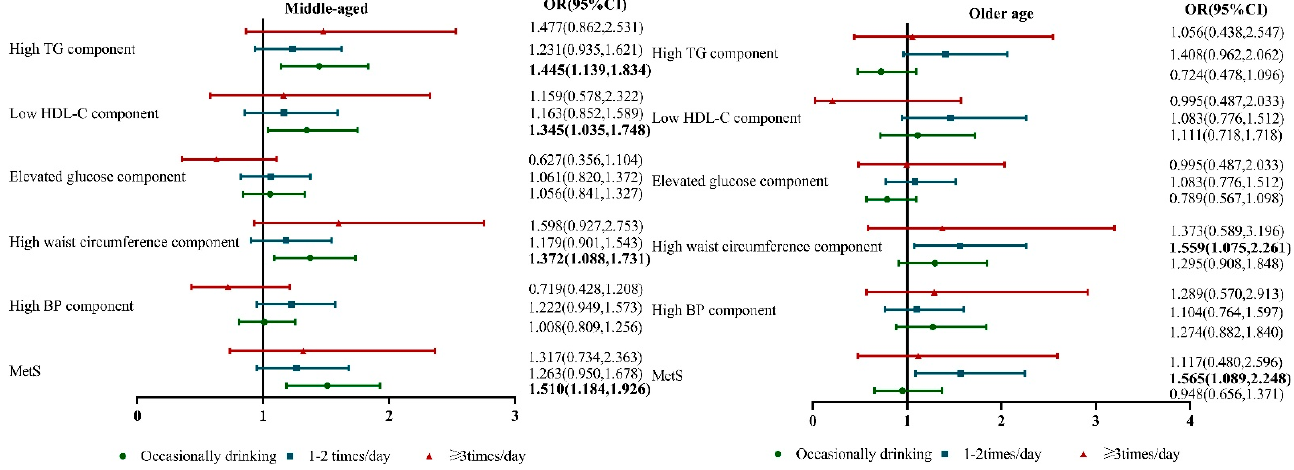
Figure 3. Multivariate logistic regression analysis estimated the possible relationship between tea consumption and metabolic disorders according to age categories [middle-aged group (between 45 to 60 year) and older-age group (more than 60 year)], adjusted for age, gender, race, current drinking and smoking status, marriage status, educational status, sleep duration, annual income, physical activity, BMI, eGFR, uric acid, AST/ALT and diet scores.